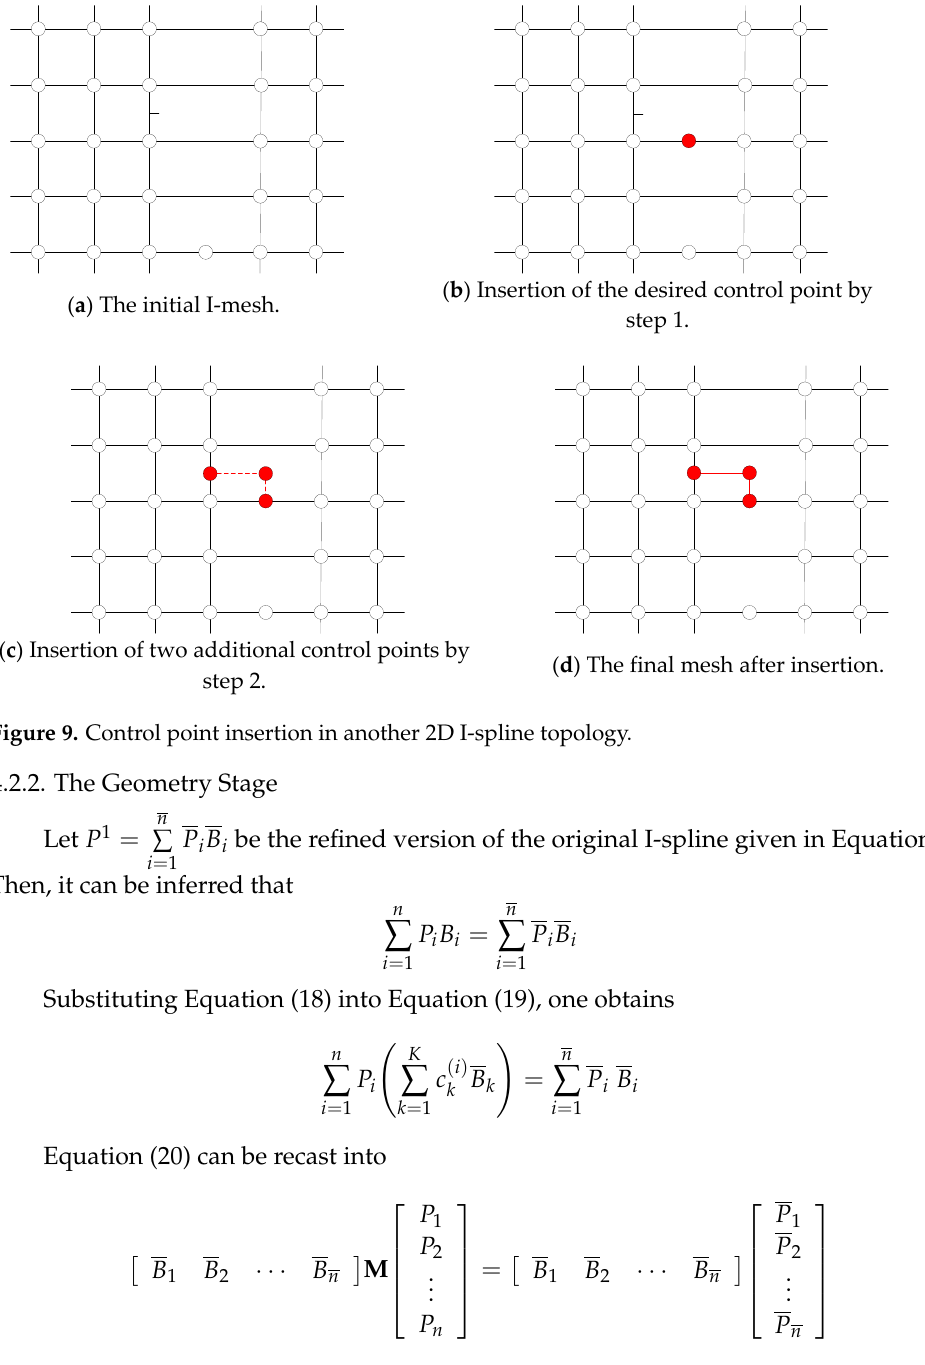
Figure 8. Control point insertion in a 2D I-spline topology.